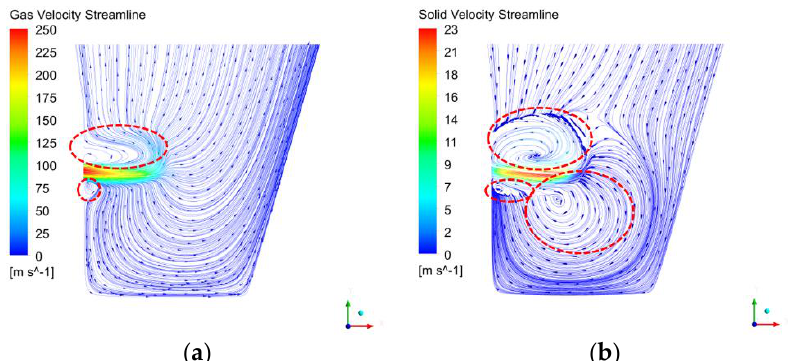
Figure 8. The symmetry plane of Case 3 at 40 s: ( a ) gas velocity streamline; ( b ) solid velocity streamline.